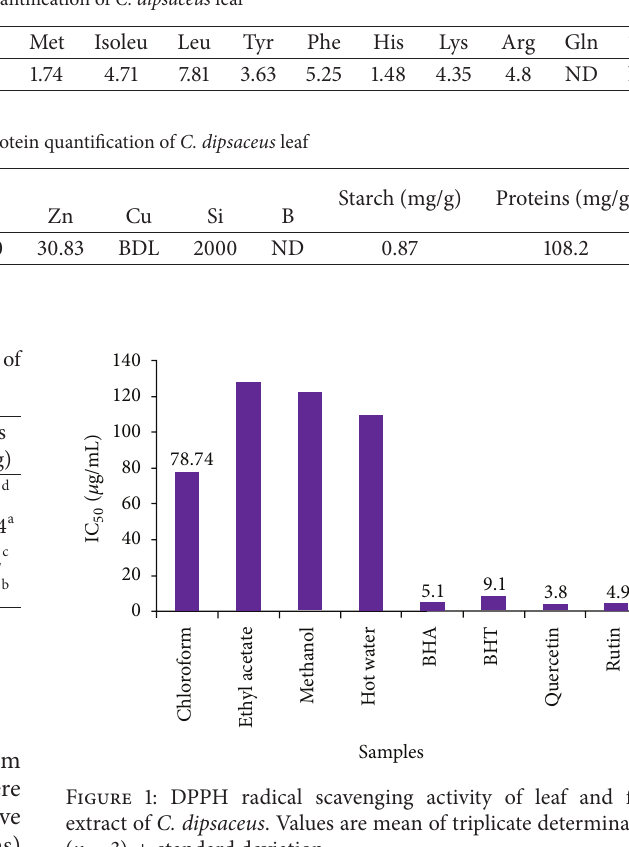
Table 2: Nutritional evaluation of C. dipsaceus leaf.